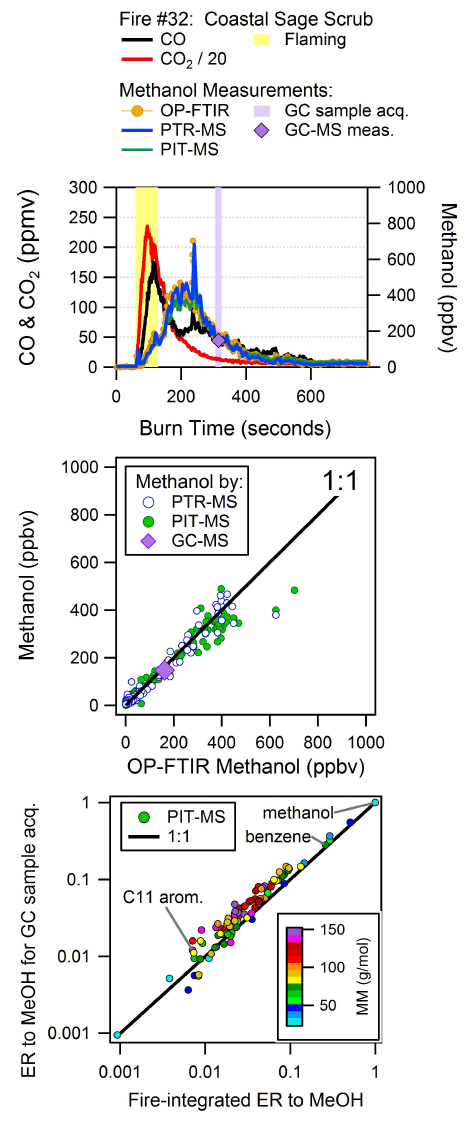
Fig. 1. (top) Time series for CO, CO 2 , and methanol for an exam- ple burn of coastal sage scrub (Fire #32). The yellow shading in- dicates the flaming-dominated period. The purple shading indicates the GC-MS sample acquisition time for this particular fire. (middle) A comparison of all other methanol measurements to the OP-FTIR methanol for Fire #32. (bottom) NMOC to methanol emission ra- tios (ER) as measured by the PIT-MS during the GC-MS sample acquisition time versus the ER determined by the PIT-MS during the entire fire for Fire #32 (see Sect.